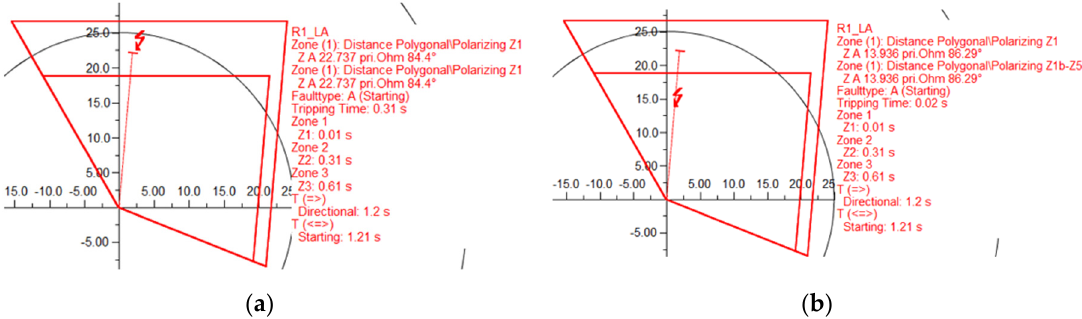
Figure 16. R-X plot for an SLG fault at 80%, with ( a ) both lines A and B, connected with no compensation ( b ) line B disconnected and earthed with no compensation.